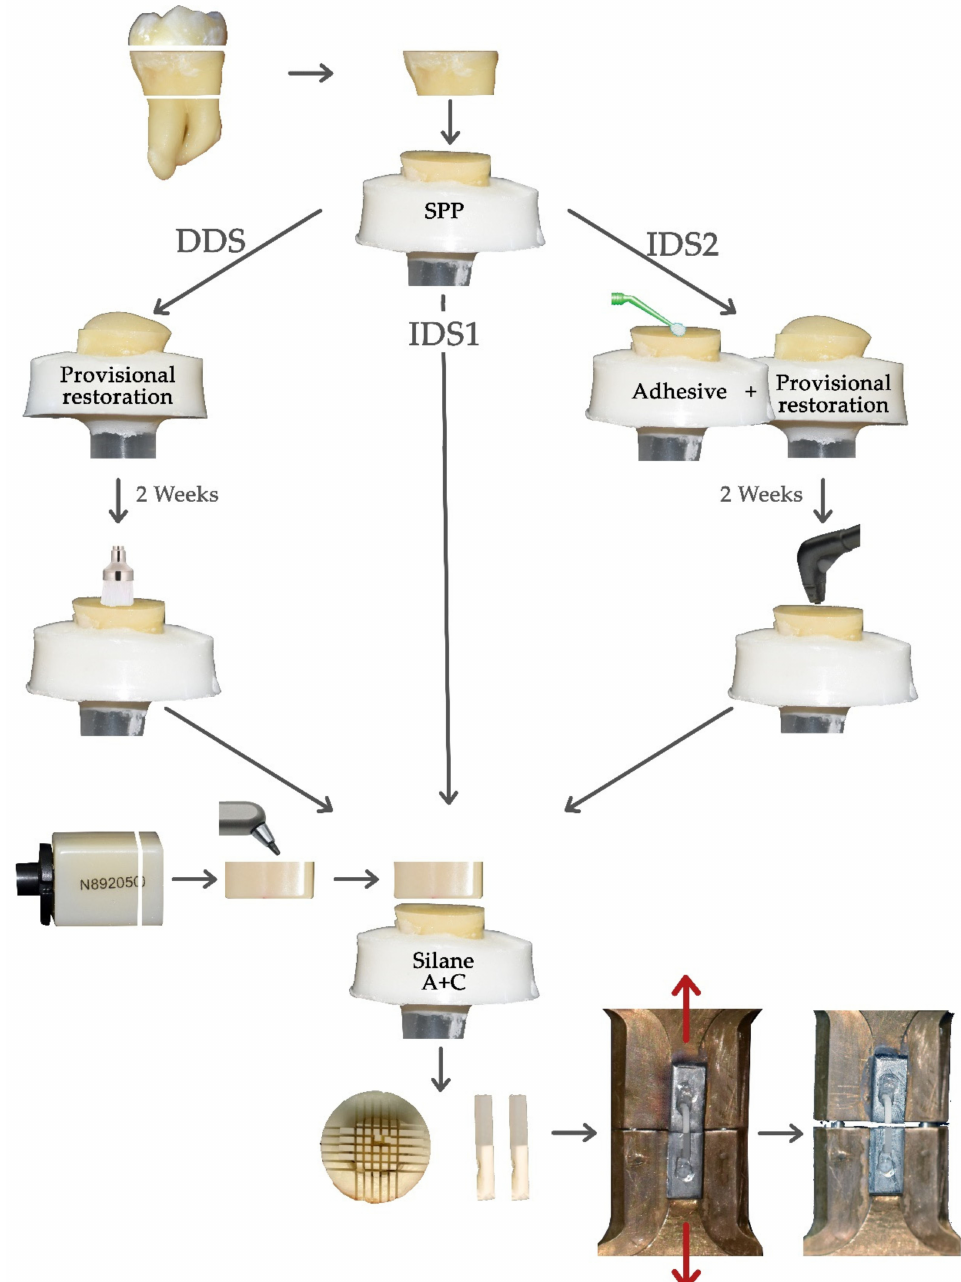
Figure 1. Sample preparation and analysis flow in the different groups. SPP: Simulated Pulp Pressure; A + C: Adhesive + Cement; DDS: Delay Dentin Sealing; and IDS: Immediate Dental